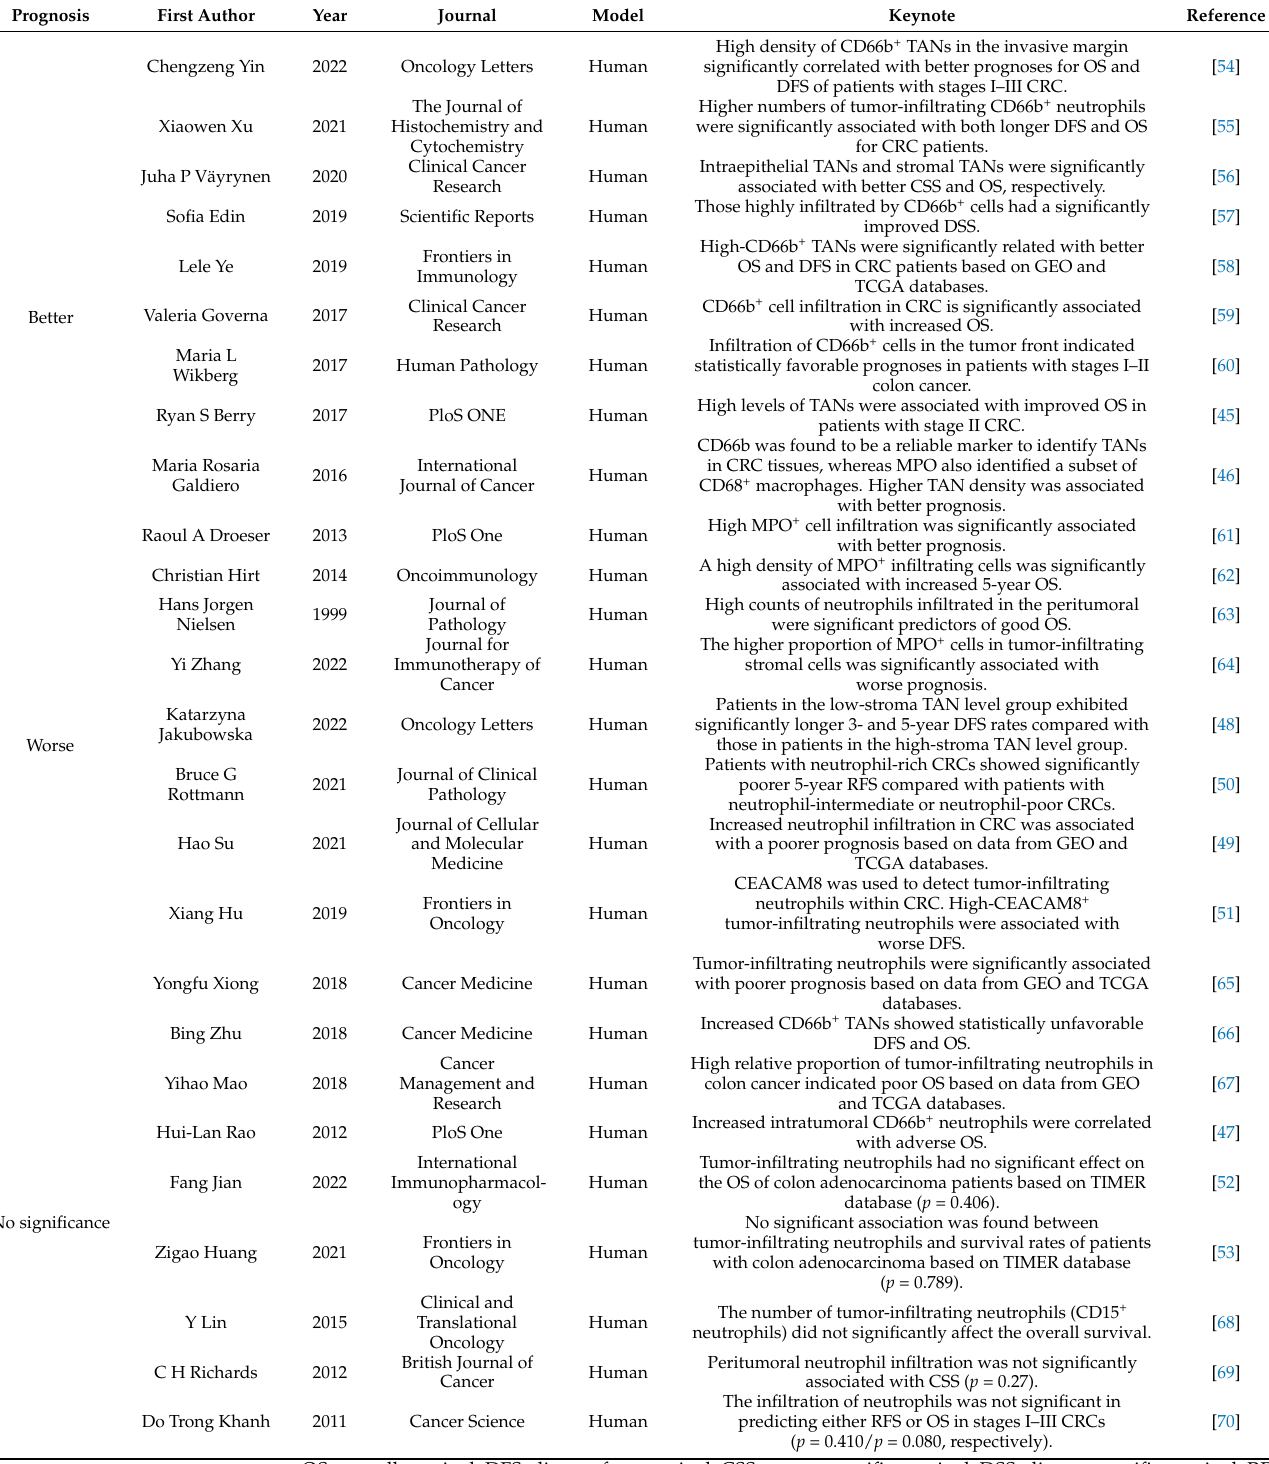
Table 1. Literature summary of prognostic role of TANs in CRC.